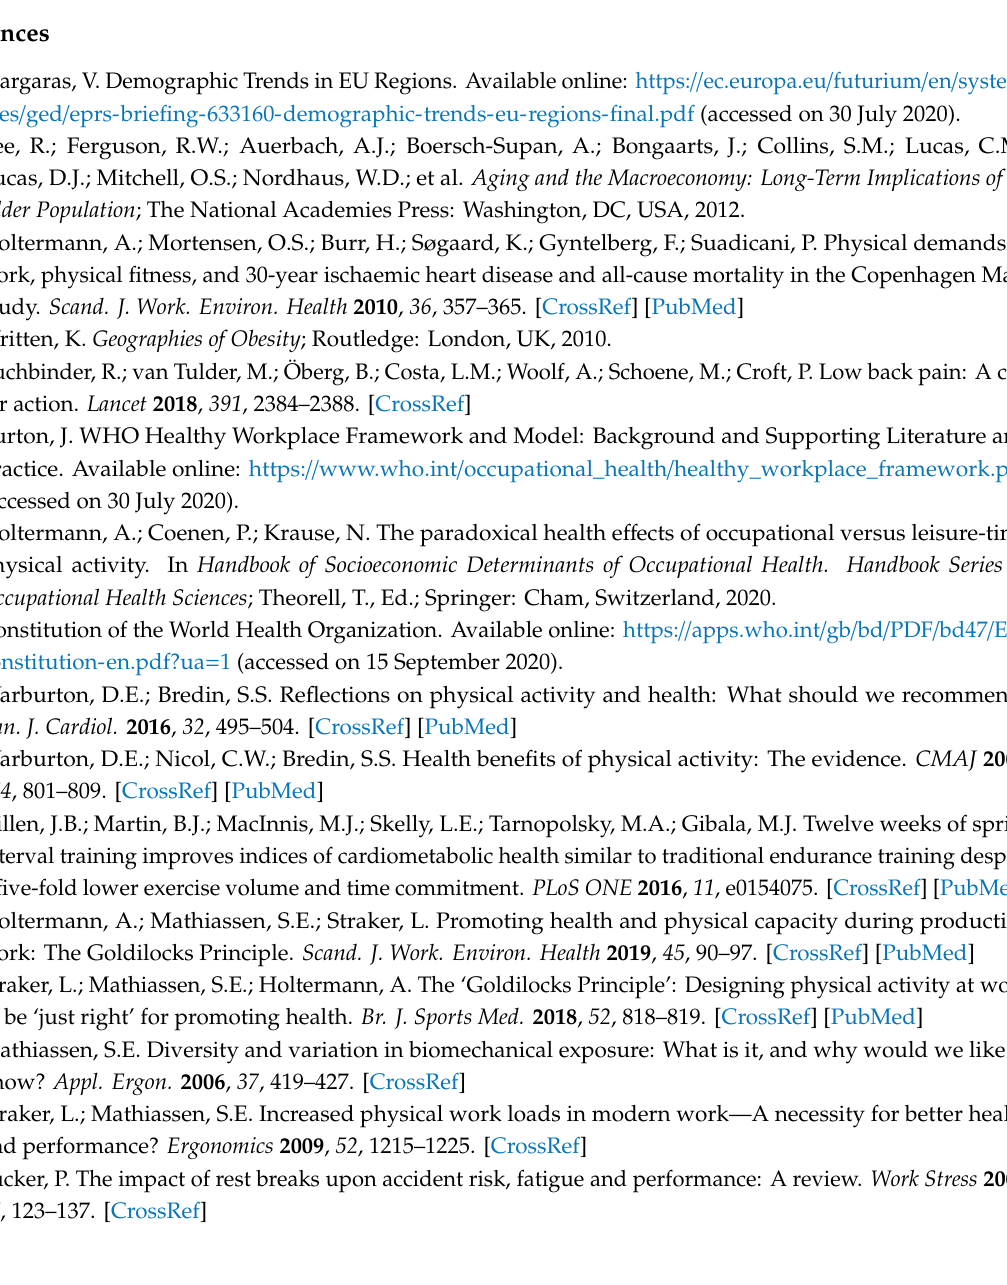
Values are presented with frequency ( n ) or group mean and standard deviation ( SD